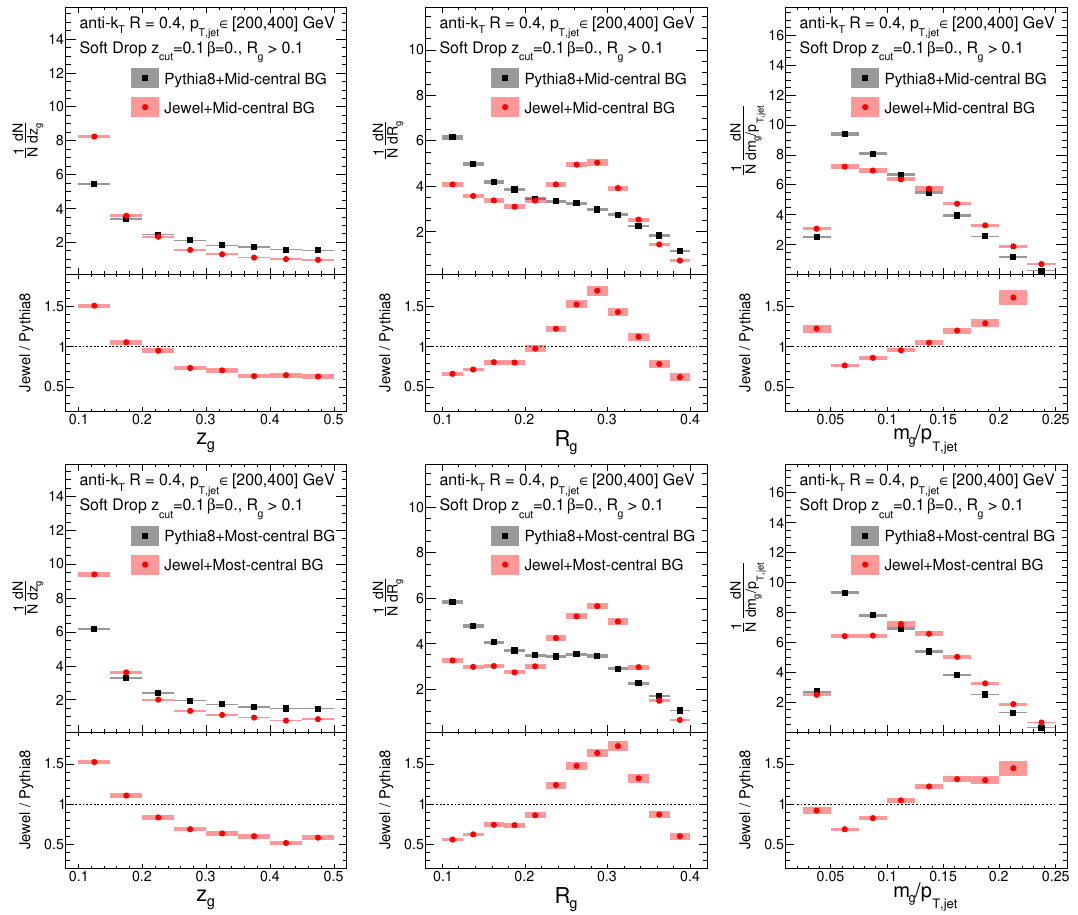
Figure 3 . Distribution of substructure variables of the groomed jets for the mid-central (upper) and the most-central (lower) mixing